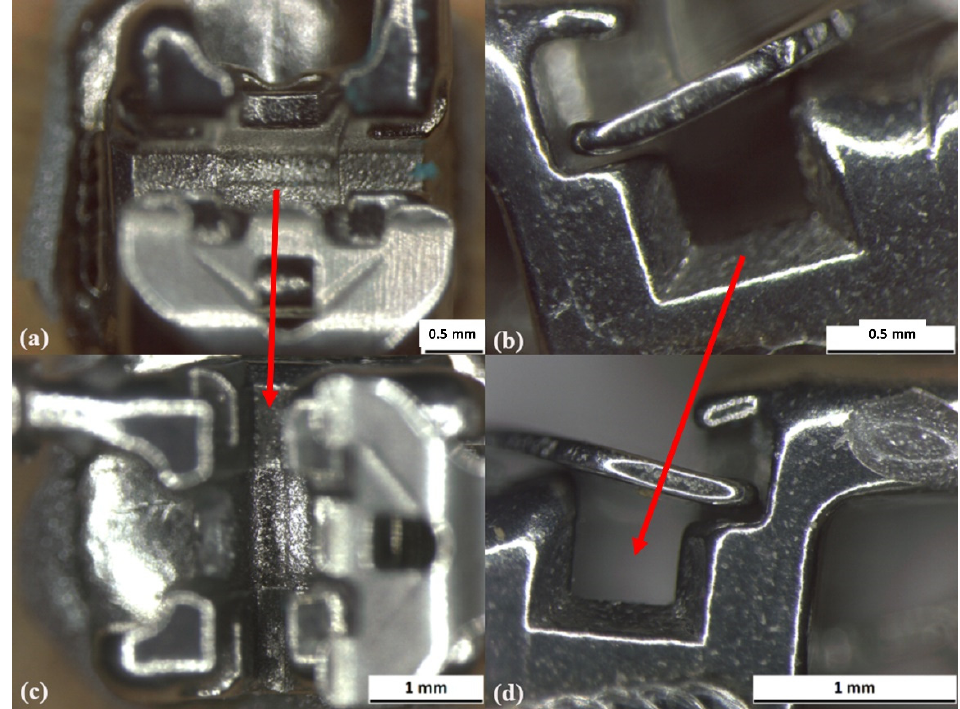
Figure 7. Empower bracket (American Orthodontics) in top and side view: ( a , b ) before the test; ( c , d ) after the test.